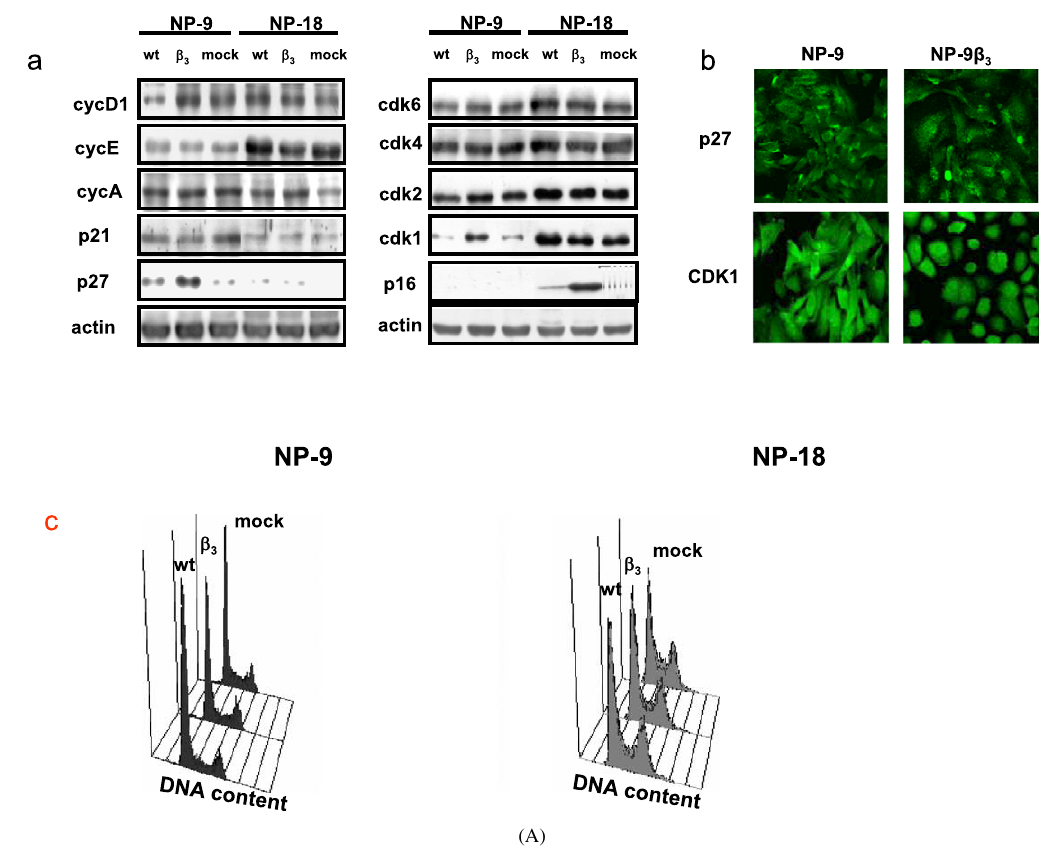
Fig. 5. Cell cycle and apoptosis analysis. (A) (a) Expression levels of cell cycle-related proteins. Two days after seeding, 40 µg of total protein extracts were immunoblotted using antibodies against different proteins involved in cell cycle progression. wt: parental, mock: mock-transfected and β 3 : β 3 -transfected. (b) Subcellular localization of p27 and cdk1 in NP-9 and NP-9 β 3 . Cells were grown for 1 day on glass coverslips in complete medium. Afterwards, cells were fixed, permeabilized and stained for p27 and CDK1 using FITC-conjugated anti-mouse IgG as secondary antibody. Samples were analyzed by fluorescence microscopy ( × 400). (c) Cell cycle profile. Cell cycle distribution was assessed by flow cytometry analysis of propidium iodide-stained cells during the exponencial phase of growth. wt: parental, mock: mock-transfectants and β 3 : β 3 -transfectants. (Colors are visible in the online version of the article;